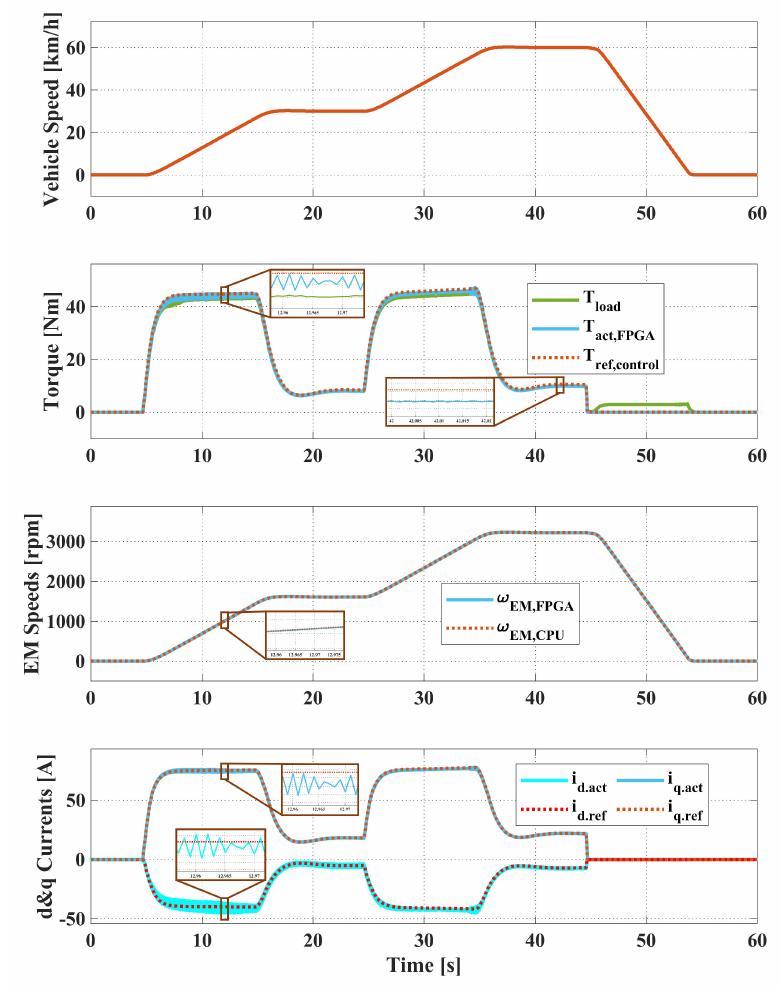
Figure 9. Speed closed-loop real-time simulation results. Electric machine speed is sent from the vehicle model to the electric drive